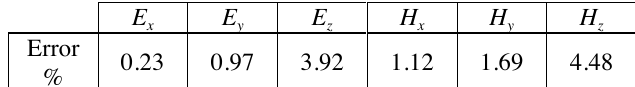
Table 2: Relative errors of E- and H-field maps obtained in the